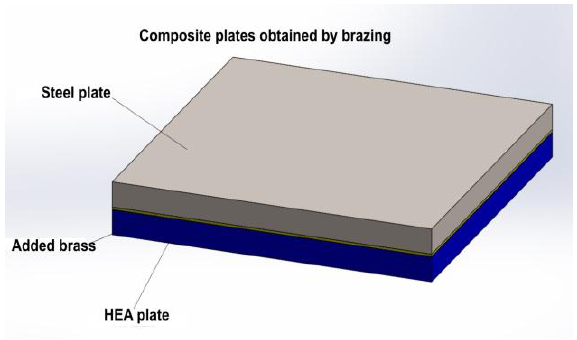
Figure 2. Composite plates welded to outline.